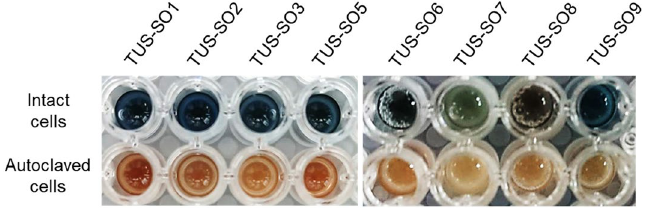
Figure 1. Colorimetric assay of 2-PAP ether bond–cleaving activity. Microbial cells after cultivation on solid basal medium supplemented with nitrohumic acid were suspended in liquid basal medium supplemented with 0.1 g/L yeast extract and 1% (v/v) Tween 80. The cell suspension was incubated with 5 mM 2-PAP for 72 h. The assay was performed by adding Gibbs reagent to the mixture following the reaction between intact cells of the isolated strains and 2-PAP. Control reactions were performed using autoclaved cells of the isolated